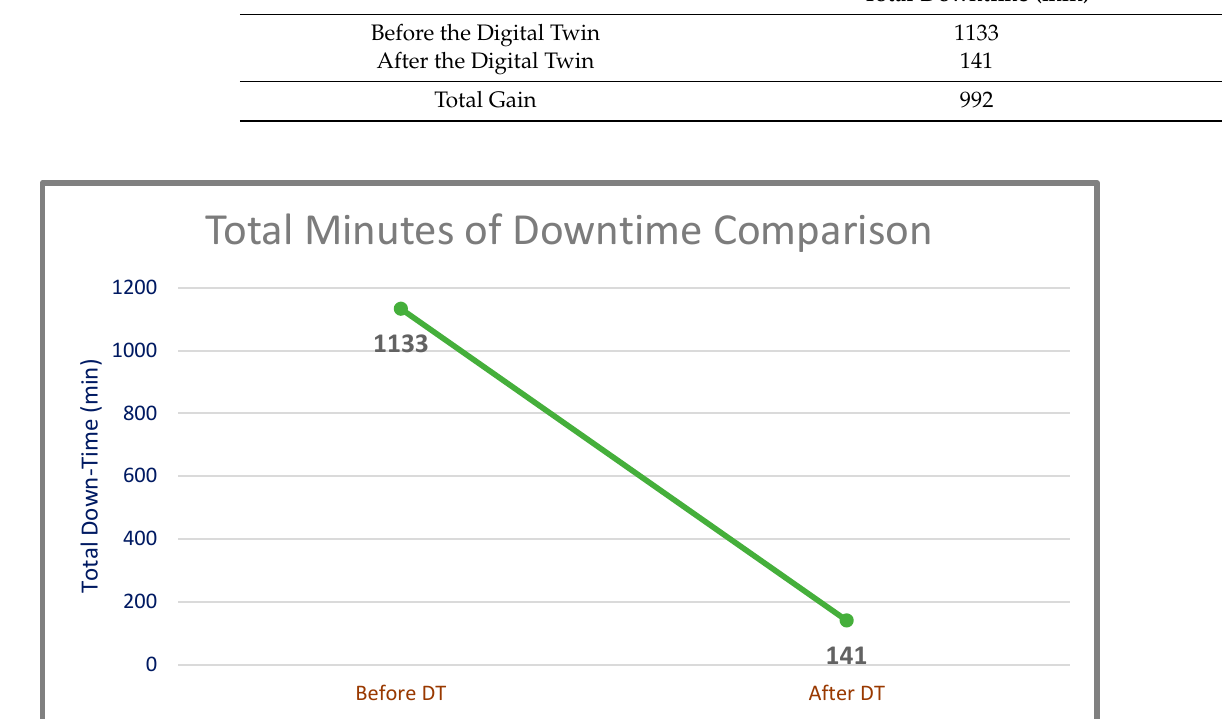
Figure 12. Total minutes of downtime comparison (before and after DT).